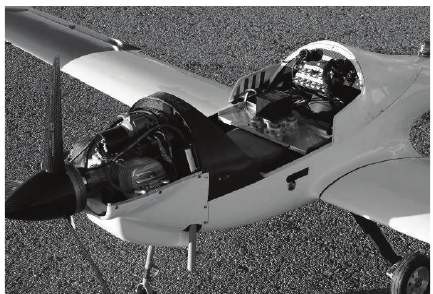
Figure 19: On-board HW equipment.